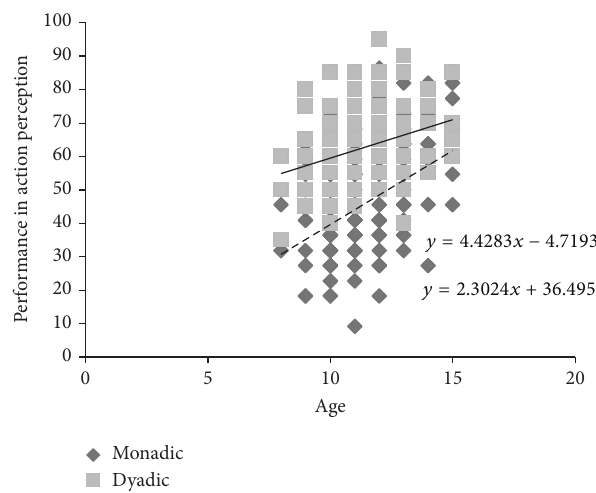
Figure 1: Performance in action perception in monadic and dyadic contexts across age. Note . Dashed line represents a regression line fit with data of monadic point lights and the solid line represents a regression line fit with data of dyadic point lights.